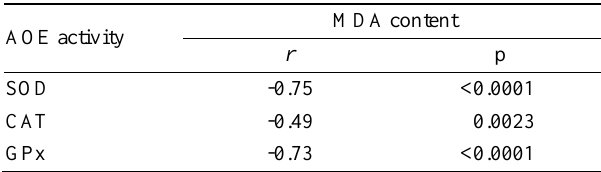
Table 5. Correlation analysis between AOE activity and MDA